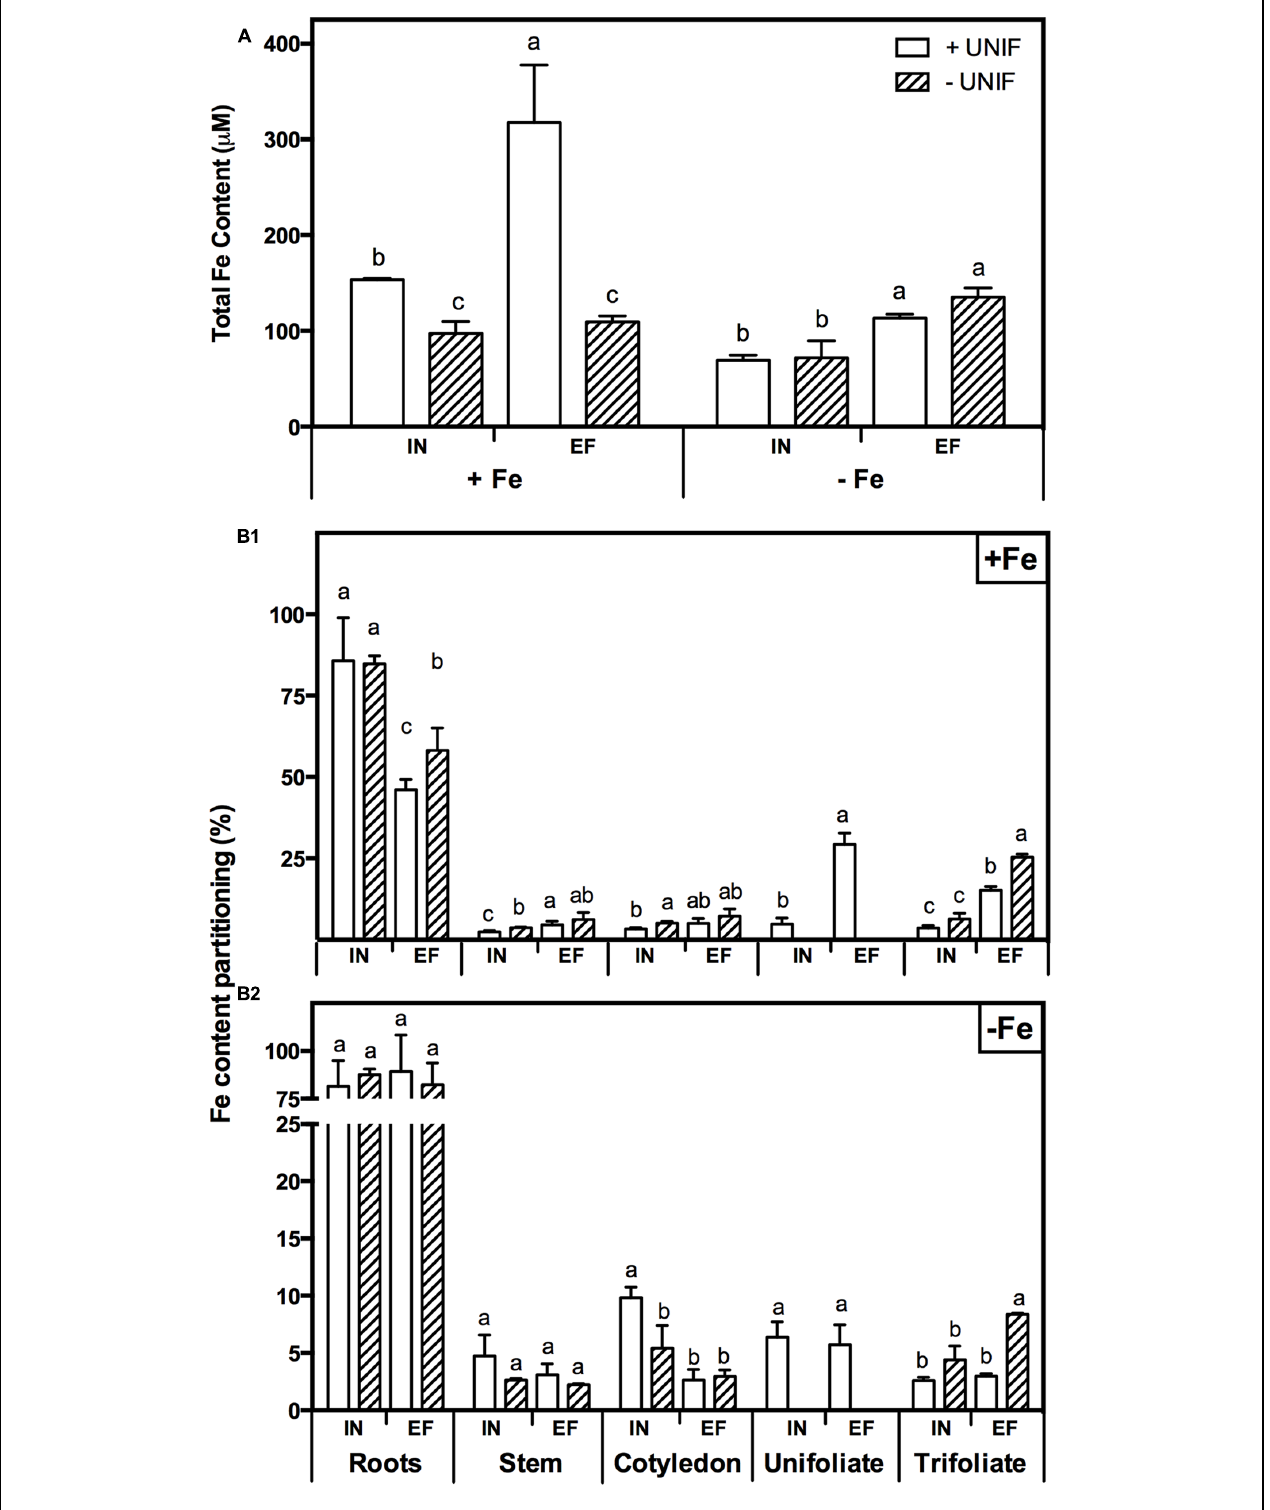
each Fe treatment different letters indicate significant differences ( P < 0.05); (B1) Fe content percentage (%) in + Fe and (B2) Fe content percentage (%) in − Fe, within each plant organ different letters indicate significant differences ( P < 0.05).